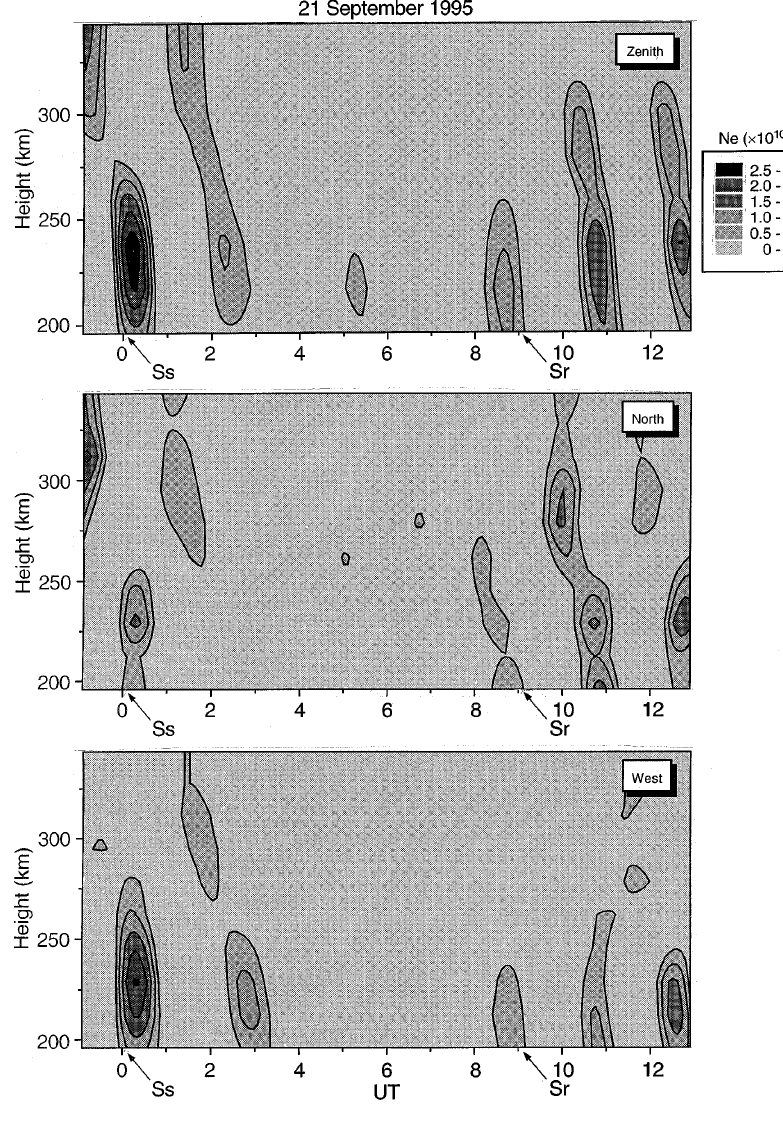
Table 3. TID phase velocity and direction of propagation of the strongest (2-h) component h ,